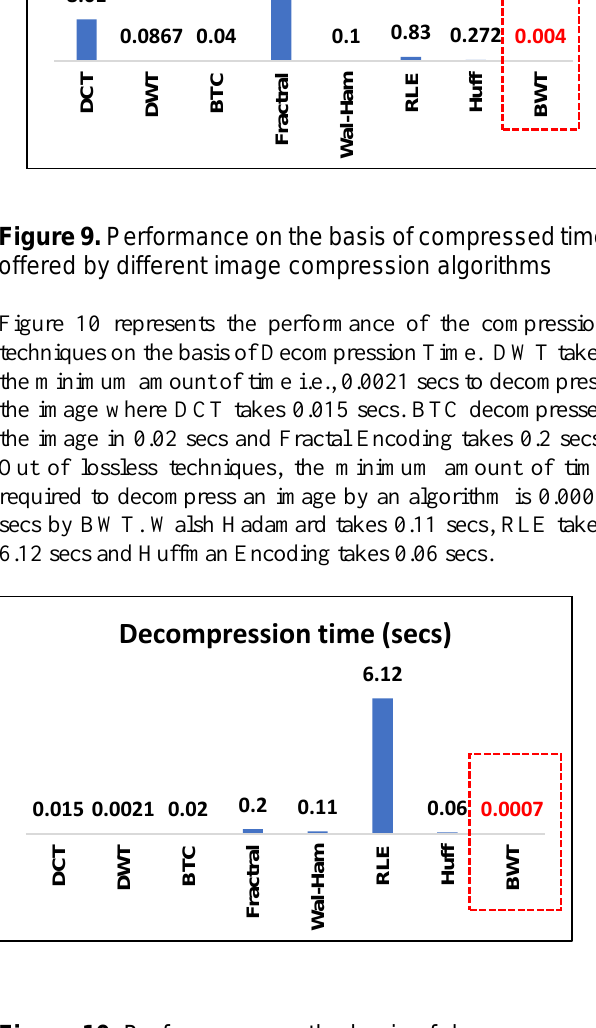
Figure 10. Performance on the basis of decompressed time offered by different image compression